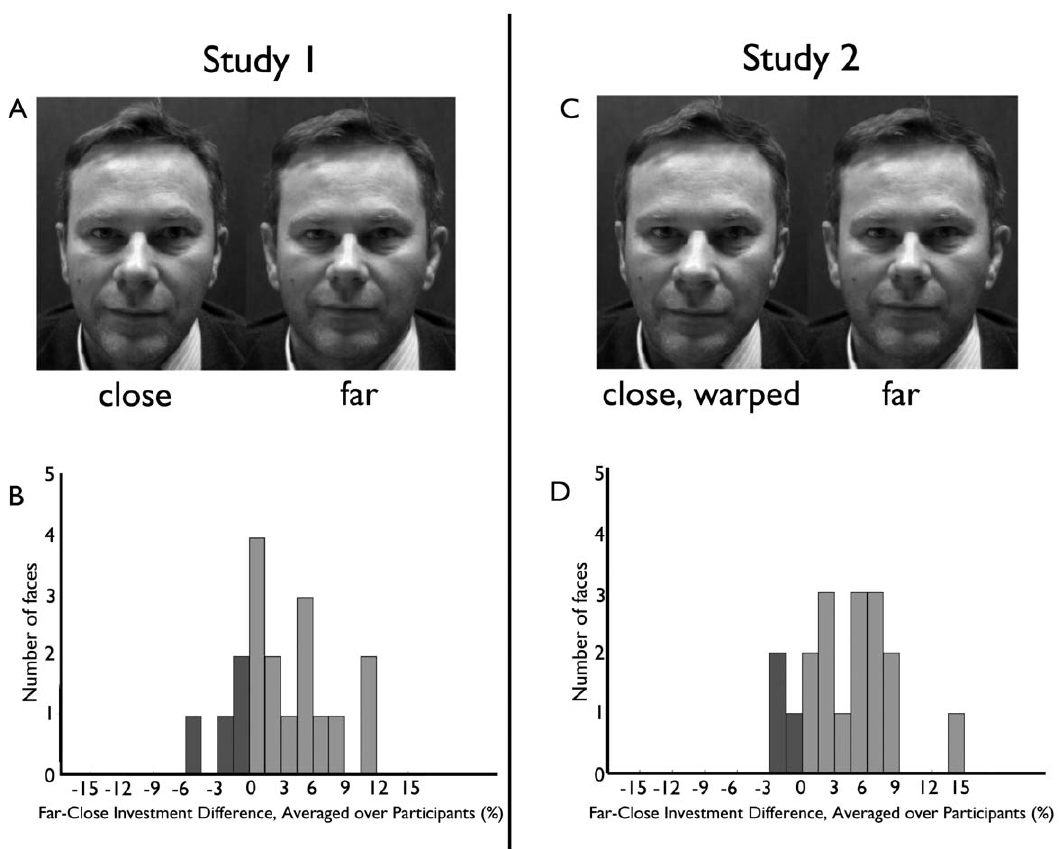
Figure 1. Perspective distortion from distance influences trust (Experiment 1a and Experiment 2). Histograms show investment difference (far-close) for each face, averaged over all participants. A disproportionately larger number of faces received a positive investment difference (light bars) compared to those receiving a negative investment difference (dark bars).